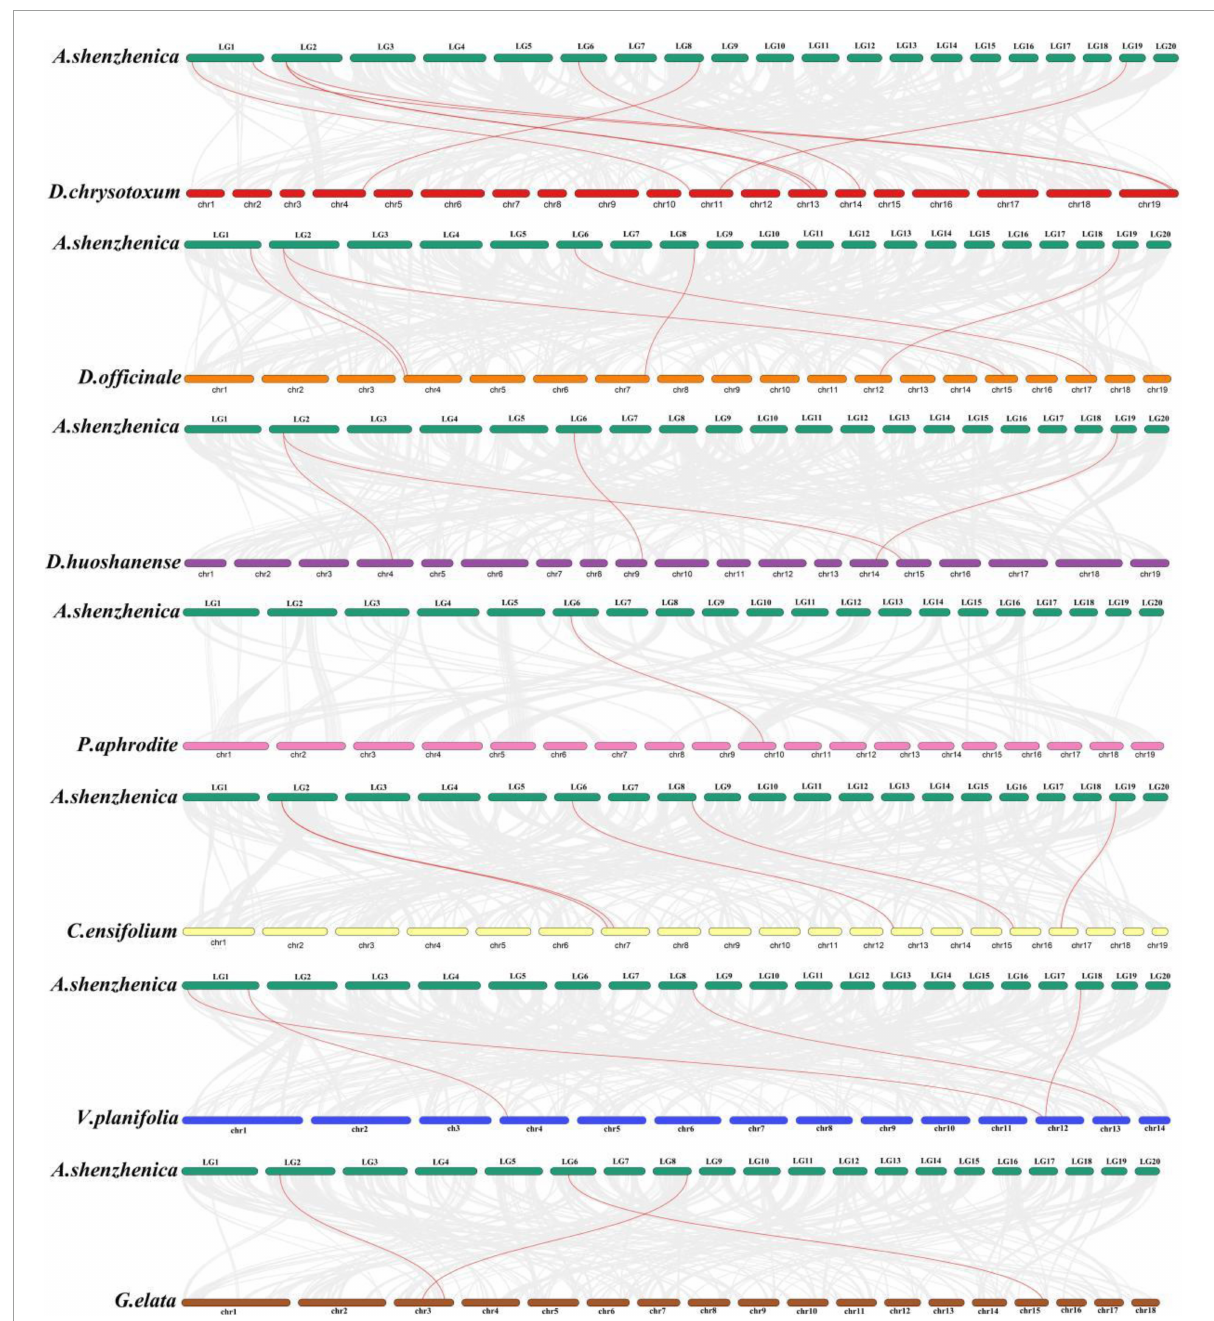
FIGURE3 The collinearity diagram between A. shenzhenica and each of other eight orchid species. Red lines highlight the homologous gene pairs of CesA/Csl genes, and gray lines represent genome-wide collinear gene pairs.